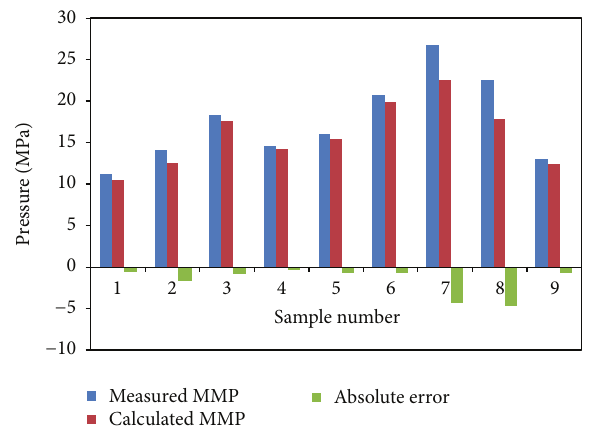
Figure 6: The MMPs of the system of nine CO 2 -oil samples and their errors predicted by the correlation proposed in this